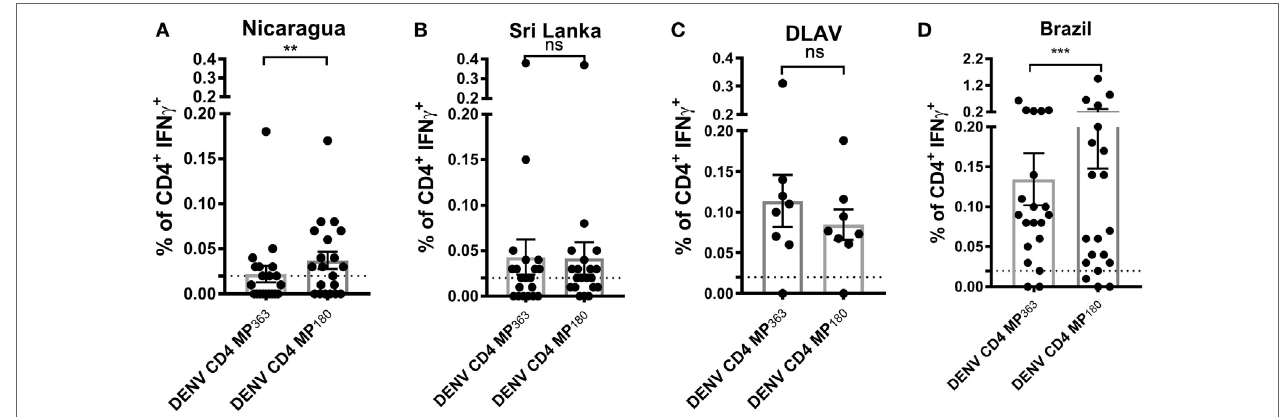
FigUre 5 | Comparison of CD4 + T cell reactivity to dengue virus (DENV) CD4 MP 363 and DENV CD4 MP 180 . Percentage of CD4 + T cells producing IFN γ upon stimulation with the two DENV CD4 MPs in Nicaraguan ( n = 20) (a) , Sri Lankan ( n = 20) (B) DLAV ( n = 8) (c) , and Brazilian ( n = 20) (D) donor cohorts. Data are expressed as mean ± SEM. Statistical analyses were performed using two-tailed Wilcoxon test. * p < 0.05; ** p < 0.01; ns, not significant. The dashed lines at 0.02% represent cutoff of